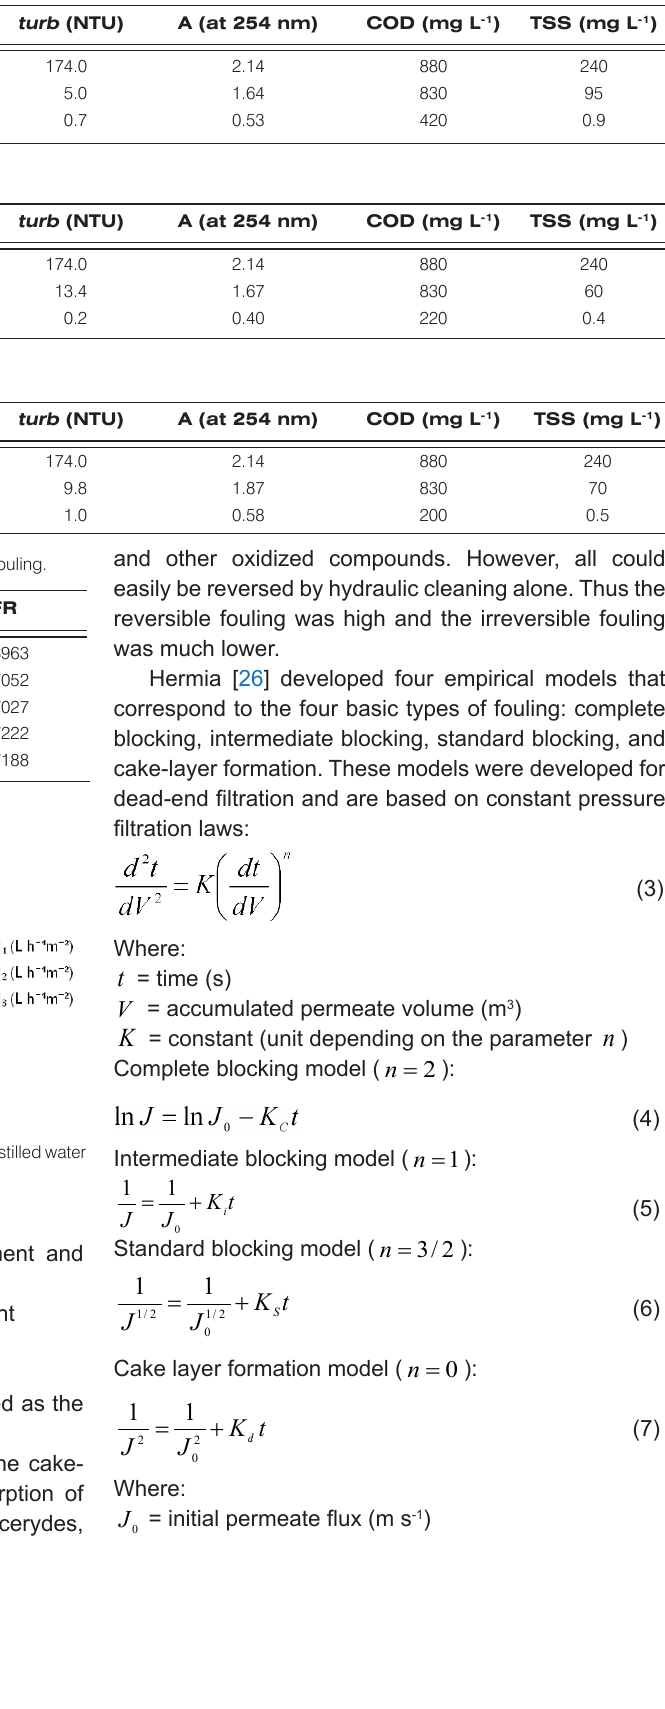
Table 6. Measurements for neutral samples.